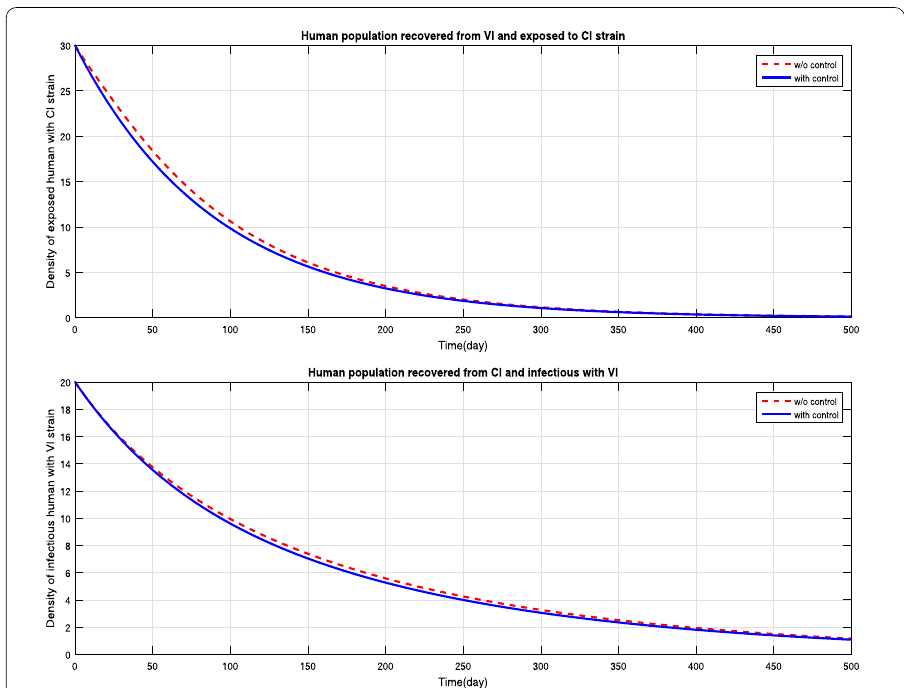
Figure 7 Comparison of behaviors with and without control in case of E 21 and I 12